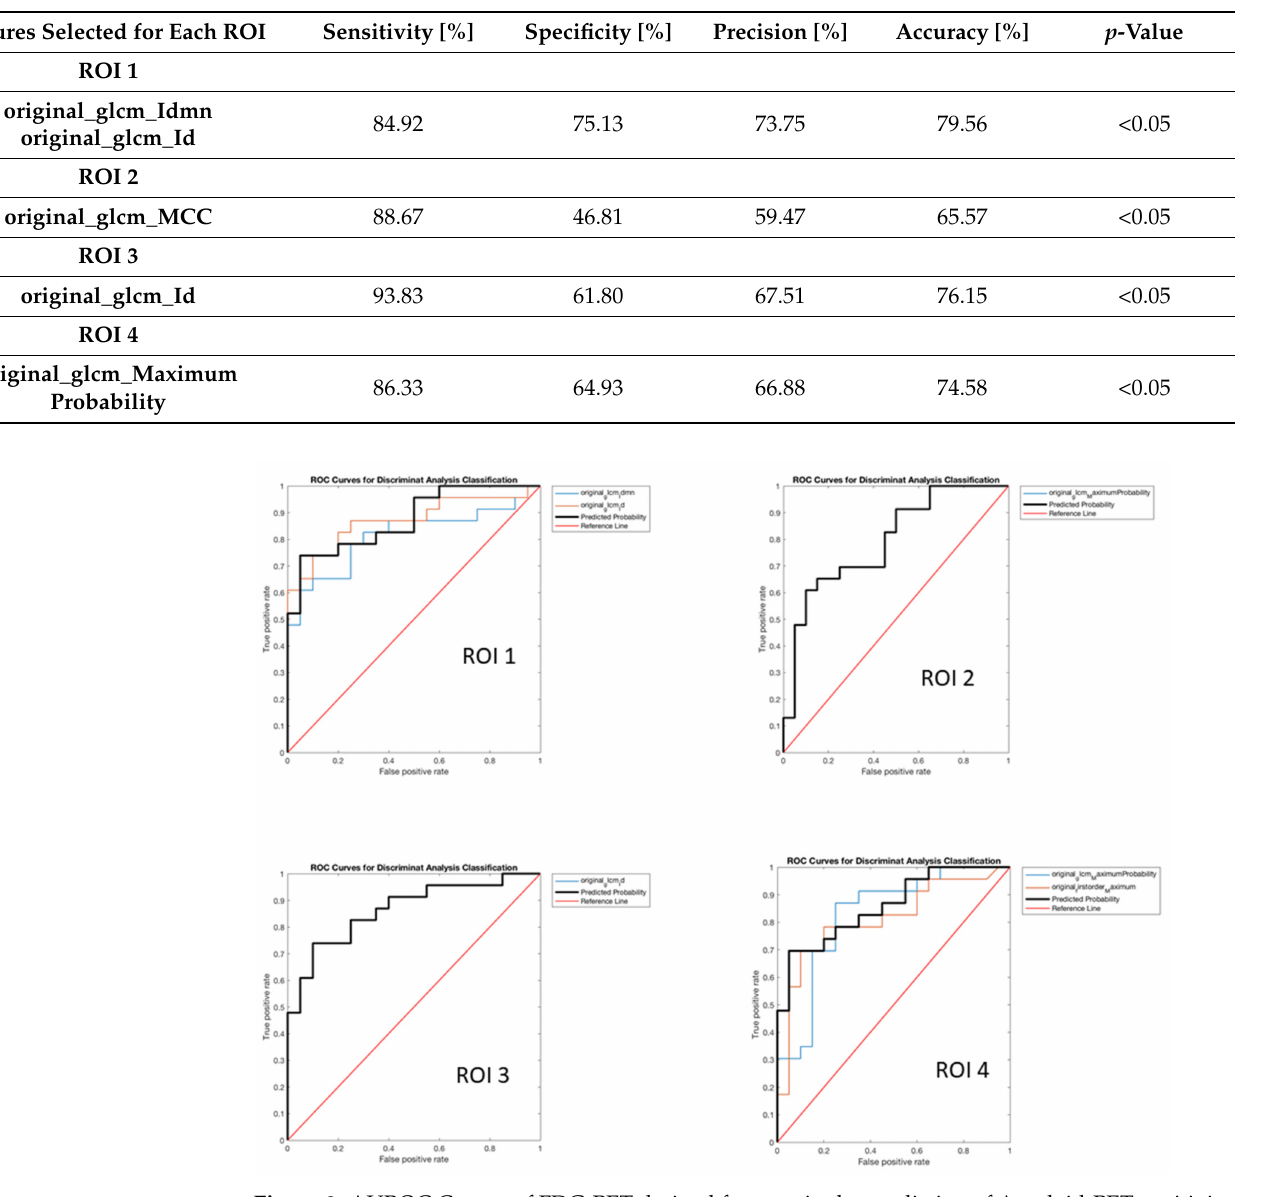
Figure 2. AUROC Curves of FDG-PET derived features in the prediction of Amyloid-PET positivity. Table 4. Performances of FDG-PET derived features in the prediction of